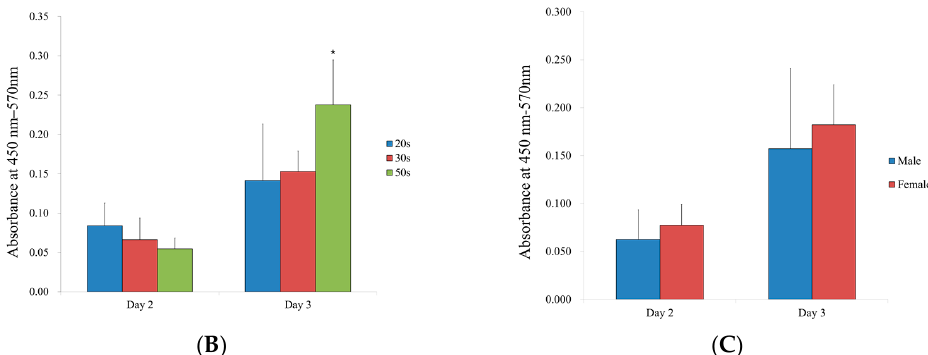
Figure 2. ( A ) Expression of the stem cell marker SSEA-4. ( B ) Secretion of vascular endothelial growth factors from BMSCs by different age groups. * Statistically significant differences were noted when compared with the results of the 20s group on Day 3. ( C ) Secretion of vascular endothelial growth factors in males and females.